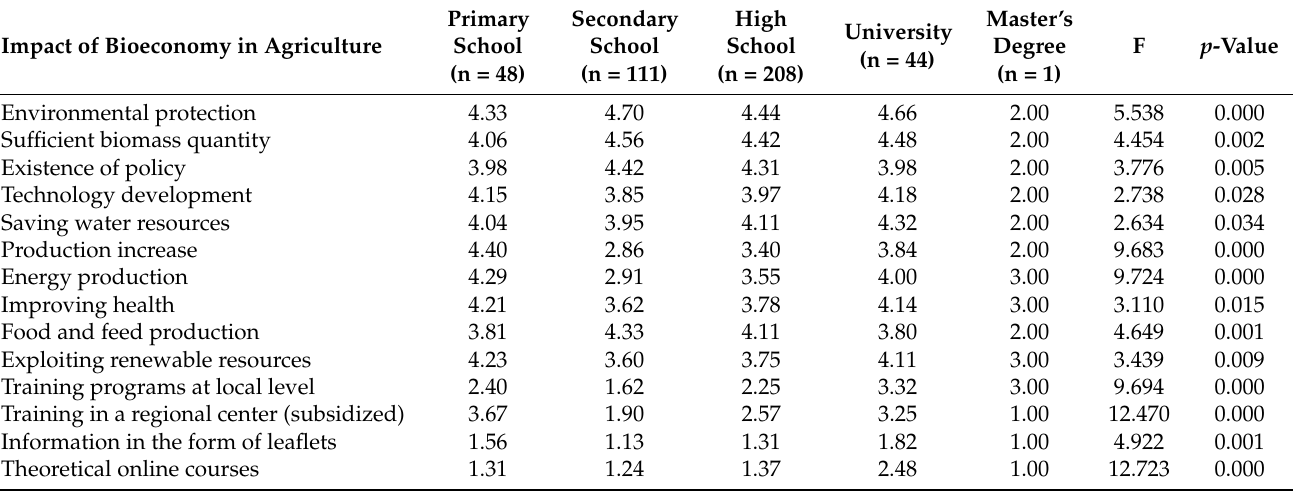
Table 4. Mean scores and ANOVA tests for education level.